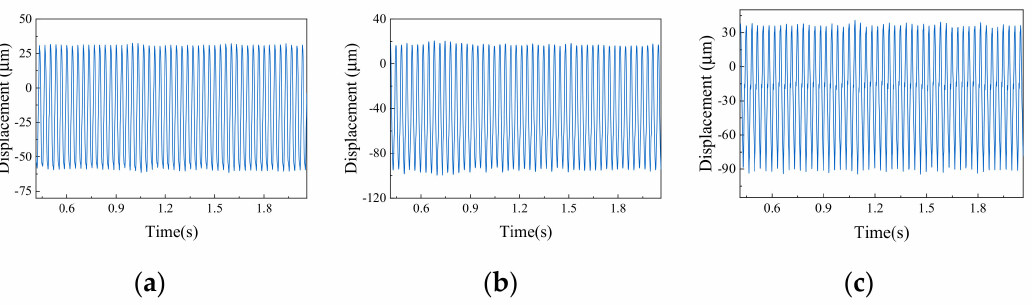
Figure 20. Rubbing faults: ( a ) value of imbalance 2.5 × 10 − 5 kg · m; ( b ) value of imbalance 5 × 10 − 5 kg · m; ( c ) value of imbalance 10 × 10 − 5 kg ·